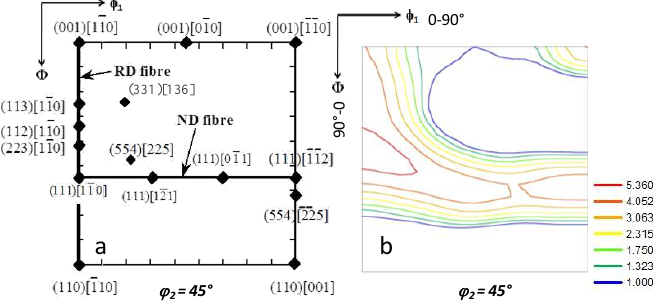
Figure 3. ( a ) Ideal positions of the most important BCC texture components in the ϕ 2 = 45° section of Euler space and ( b ) plot of ODF of the cold rolled steel used in this work.